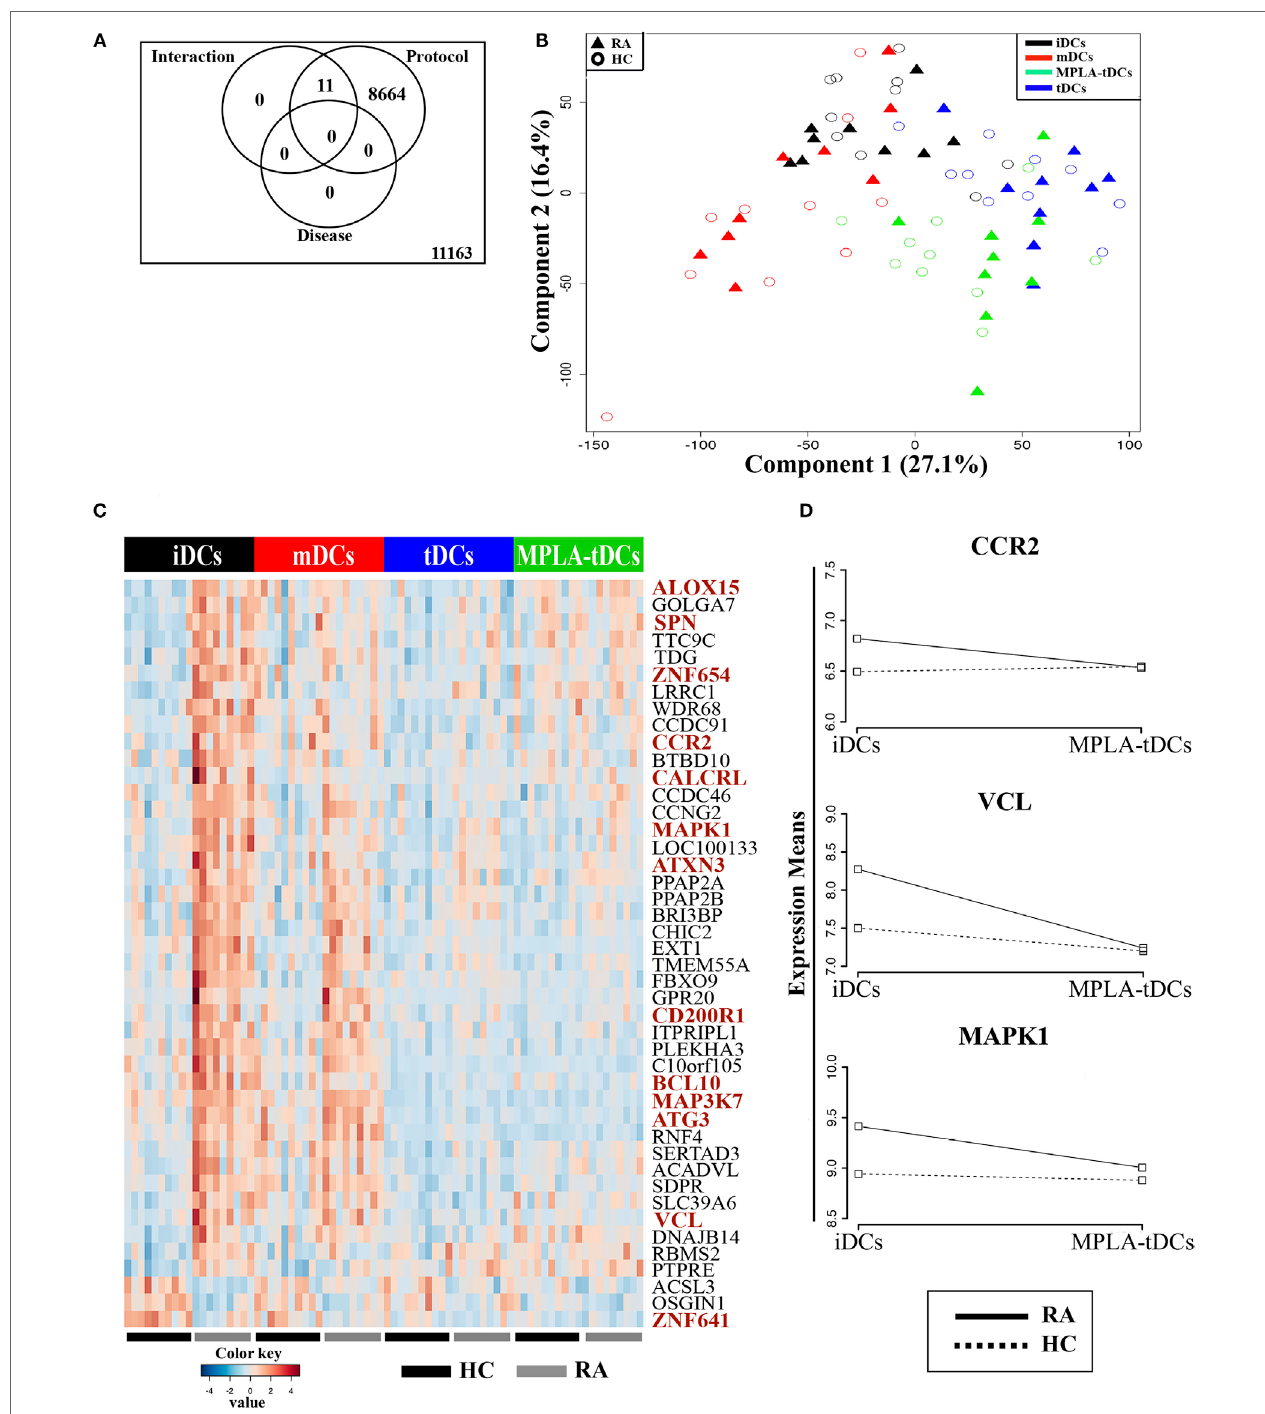
FigUre 5 | conditioning with dexamethasone and MPla induces similar transcriptional profiles on monocyte-derived Dcs from rheumatoid arthritis patients and healthy controls and counterpoints disease-associated effects on gene expression . (a) Venn diagram displaying numbers of differentially expressed (DE) transcripts due to differentiation protocol (iDCs, mDCs, tDCs, or MPLA-tDCs), presence of disease (healthy controls: HC, or rheumartoid arthritis: RA) or interaction of protocol and disease. (B) Principal component analysis using the first two components separates samples according to their variance. (c,D) Pairwise comparison between moDCs from RA patients and HC were performed for each differentiation protocol separately using t -test. (c) 44 DE genes found exclusively in iDCs were hierarchically clustered. Genes with known or potential association to RA are highlighted in red color. (D) Changes in means of expression of selected RA-associated DE genes in iDCs vs. MPLA-tDCs were shown for HC and RA patients. iDCs, unstimulated immature DCs; tDCs, dexamethasone- modulated TolDCs; mDCs, MPLA-matured DCs; MPLA-tDCs, dexamethasone-modulated MPLA-activated